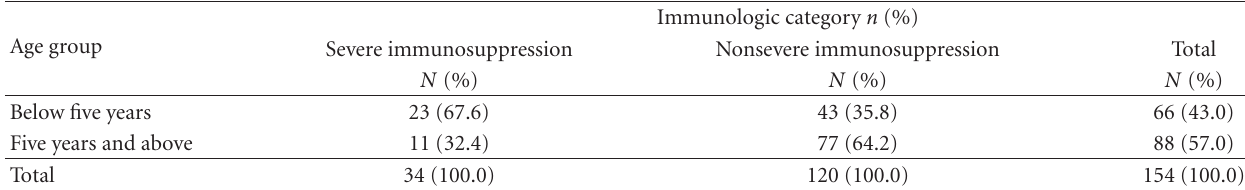
Table 3: Immunologic status of HIV-positive subjects for